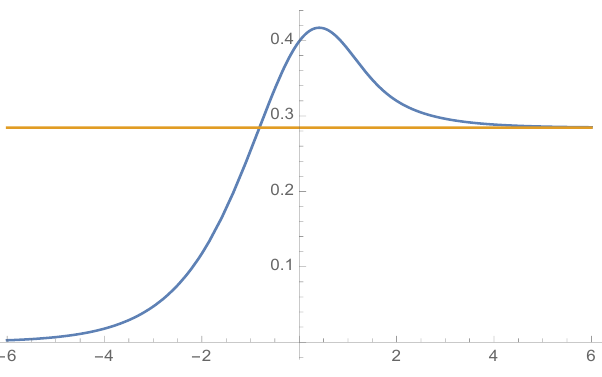
Figure 1 . Pro(cid:12)le of the tachyon (cid:12)eld T ( x ) as a function of x + 2 [ (cid:0) 6 ; 6] for the light-like rolling tachyon solution. In this and subsequent plots we set (cid:12) = j (cid:21) j = 1. The (cid:13)at line indicates the expectation value at the tachyon